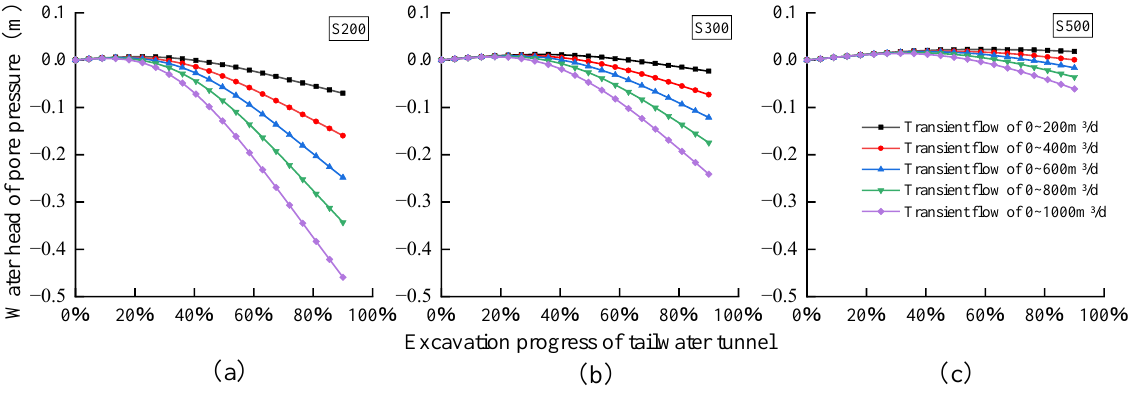
Figure 12. Variations in the water level at different distances under normal seepage conditions. (( a ) is change of water level at 200 m from the axis of the tunnel, ( b ) is change of water level at 300m from the axis of the tunnel, ( c ) is change of water level at 500 m from the axis of the tunnel)